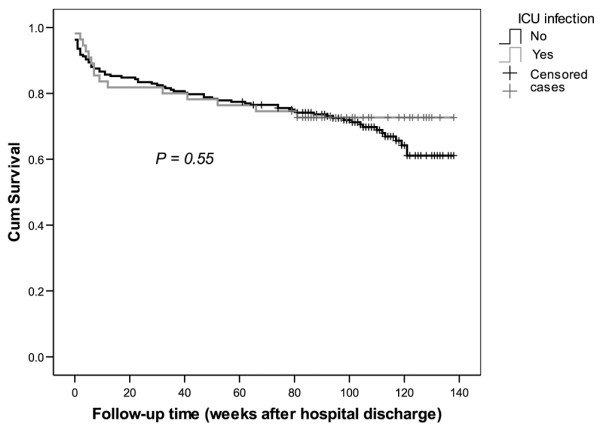
Survival curves of ICU patients after discharge from hospital. The patients who were alive on 25 January 2005 were censored. ICU, intensive care unit.